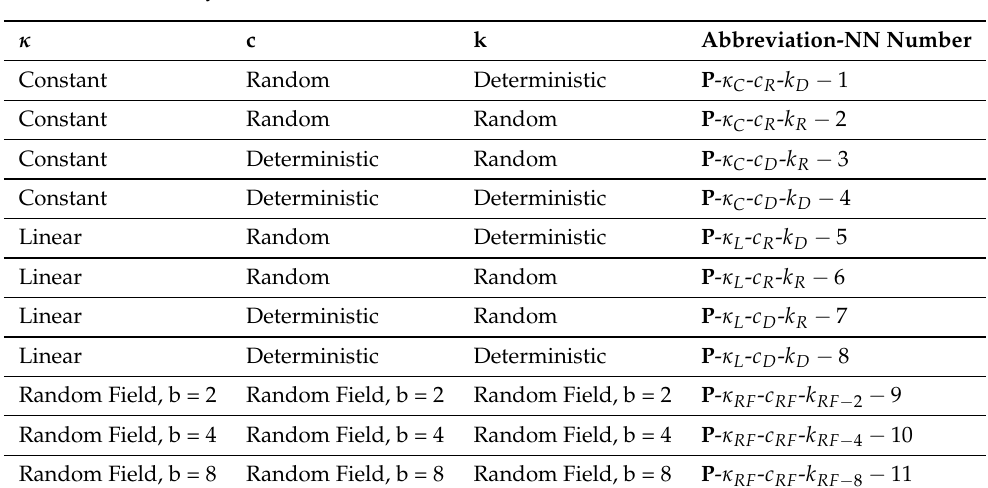
Table 2. Porous analyses